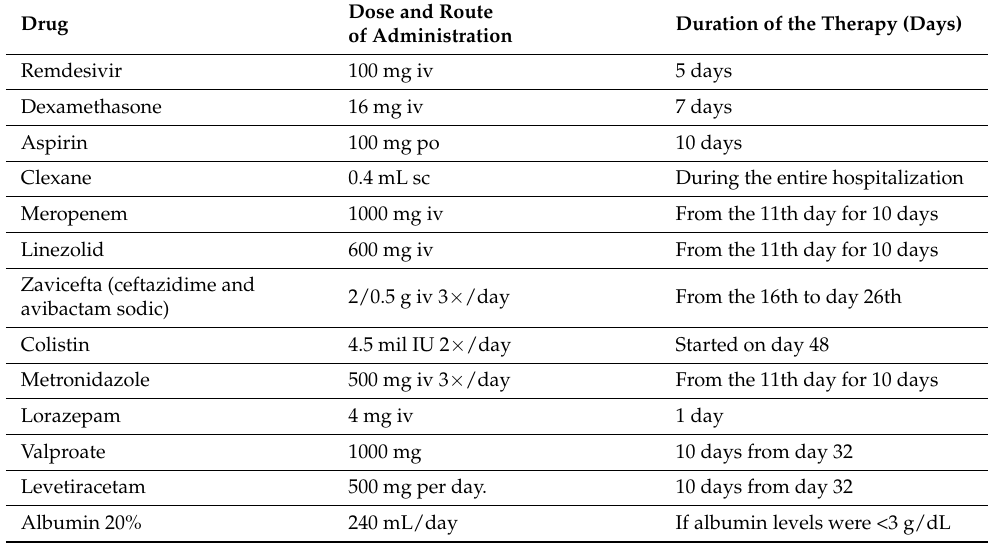
Table 3. Summary of drug therapy during